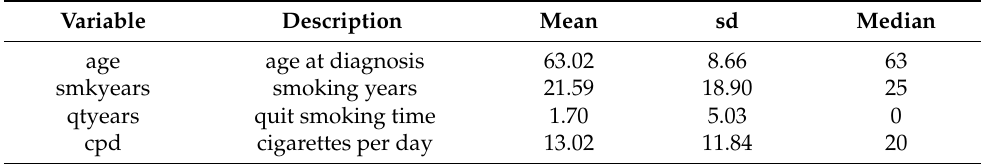
Table 3. Descriptive statistics of continuous predictors available in the Domestic Lung Cancer Database. Variable